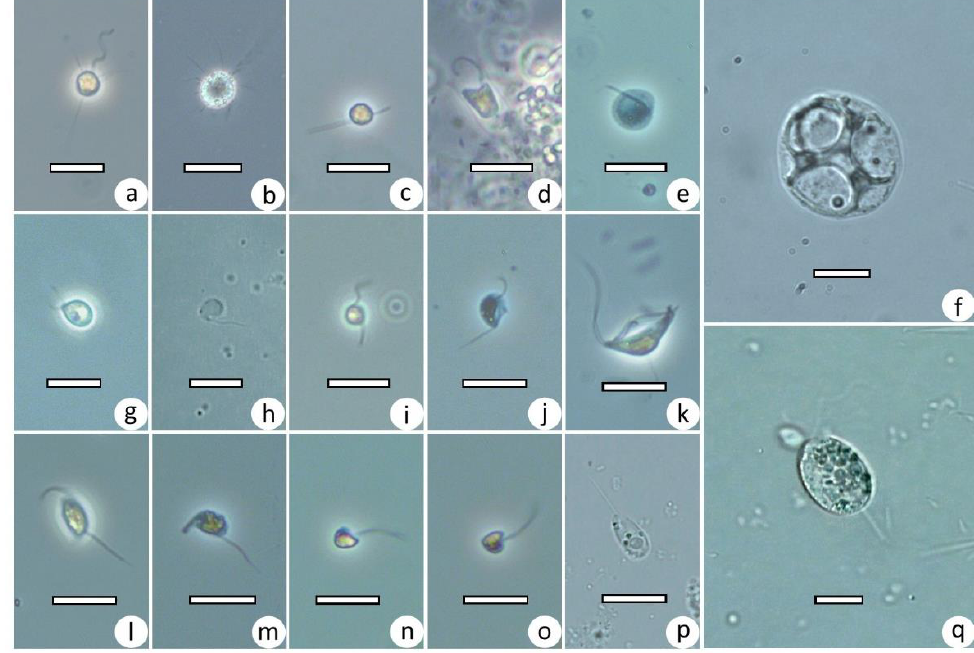
Figure 3. Light microscopy of the heterotrophic flagellates observed: ( a ) Pteridomonas danica ; ( b ) Actinomonas mirabilis ; ( c ) Caecitellus parvulus ; ( d ) Bicosoeca cf. maris ; ( e ) Discocelis saleuta ; ( f ) Ebria tripartita ; ( g ) Telonema sp.; ( h ) Ancyromonas sigmoides ; ( i ) Eoramonas cf. jungensis ; ( j ) Kipferlia bialata ; ( k ) Reclinomonas americana ; ( l ) Neobodo designis ; ( m ) Rhynchomonas nasuta ; ( n , o ) unidentified protist; ( p ) Petalomonas poosilla ; ( q ) Neometanema exaratum . Scale bars: 10 µm.